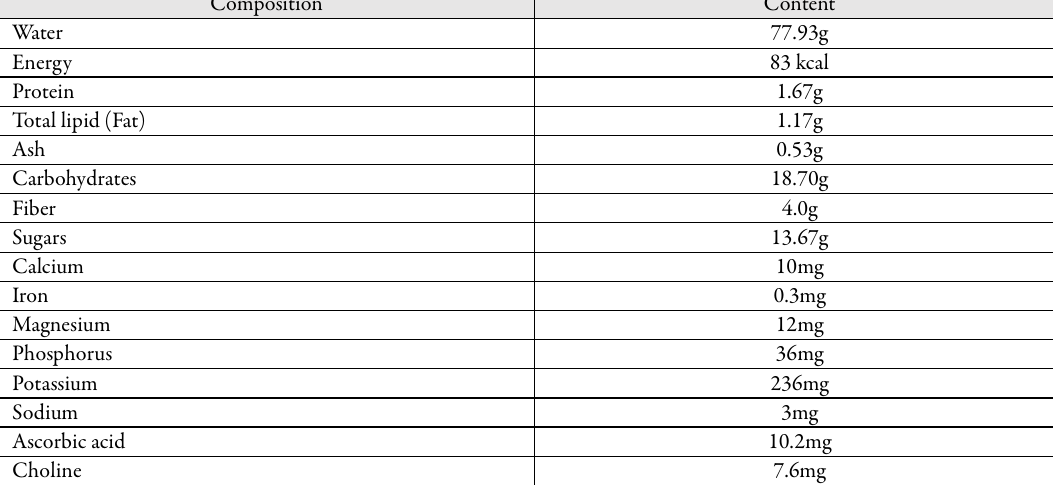
Table 1. Pomegranate’s nutrient values for 100 g (Ahmad et al ., 2018)